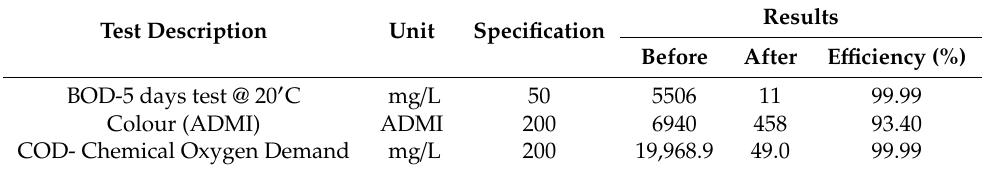
Table 4. Comparison of e ffl uent parameters before and after treatment with LLDPE / 3ZT-CO /